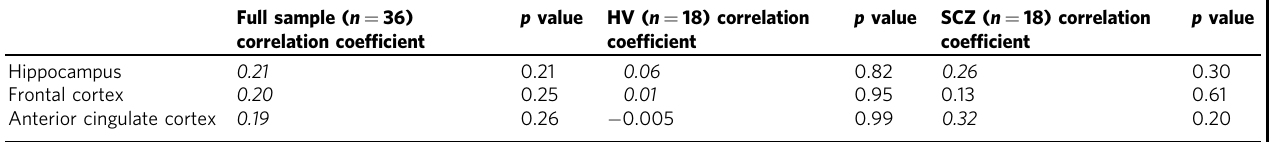
Table 1 Associations between corrected grey matter volume and [ 11 C]UCB-J V T .